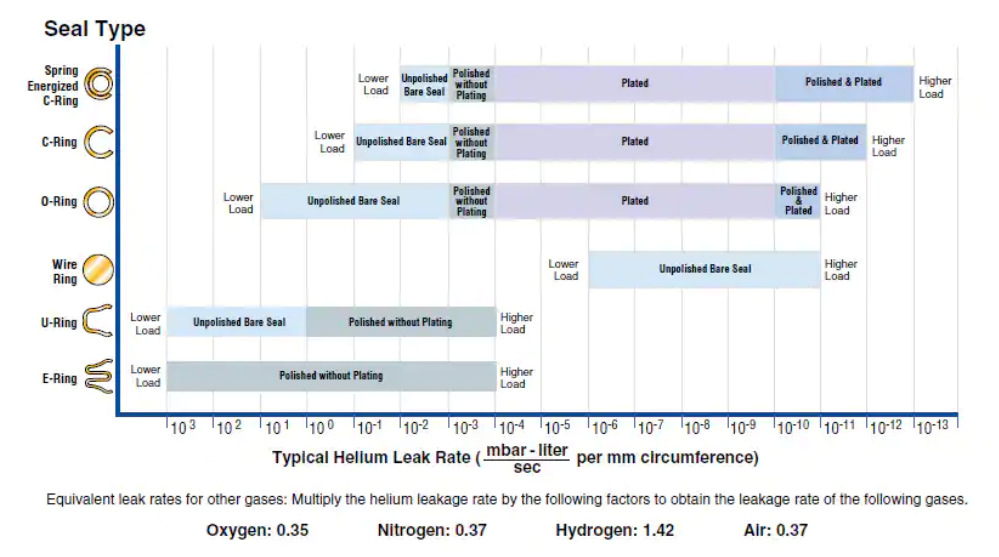
Figure 2. Leak rates for different seals depending on finish